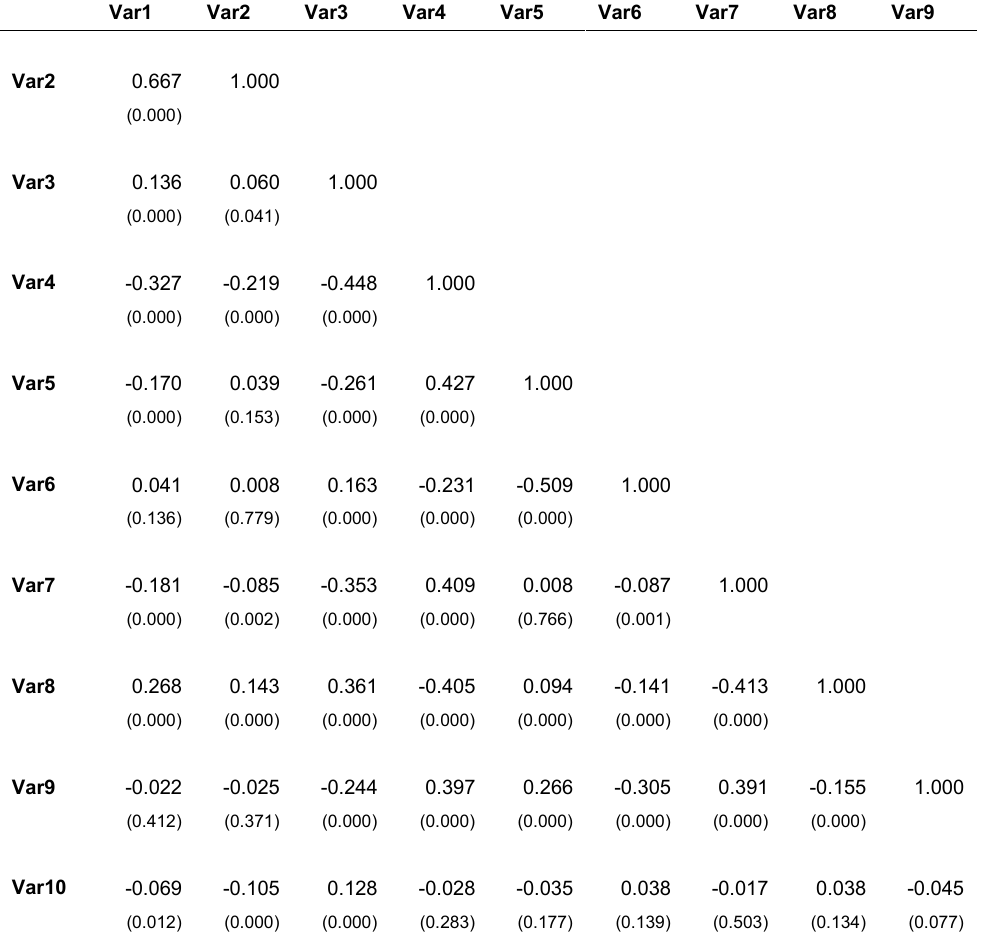
Table A1 . Correlation Matrix for Variables of Models 1 and